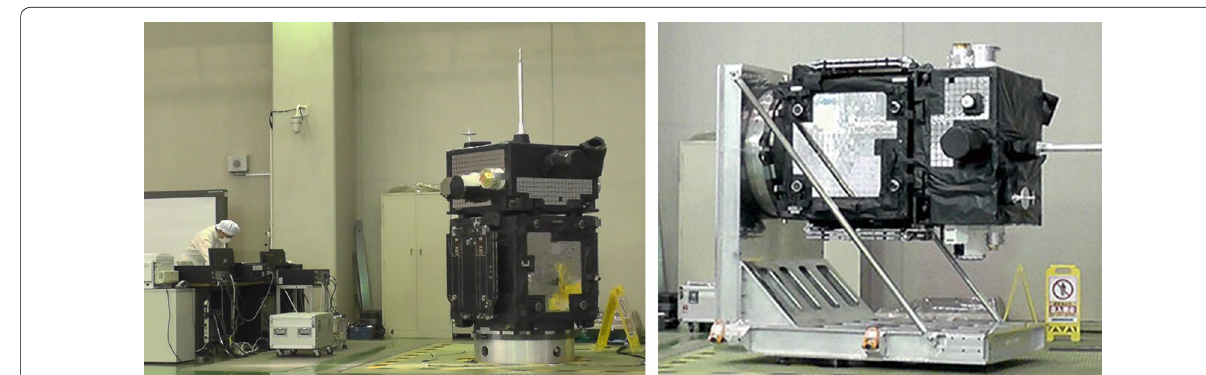
Fig. 8 Test of the mass properties of the